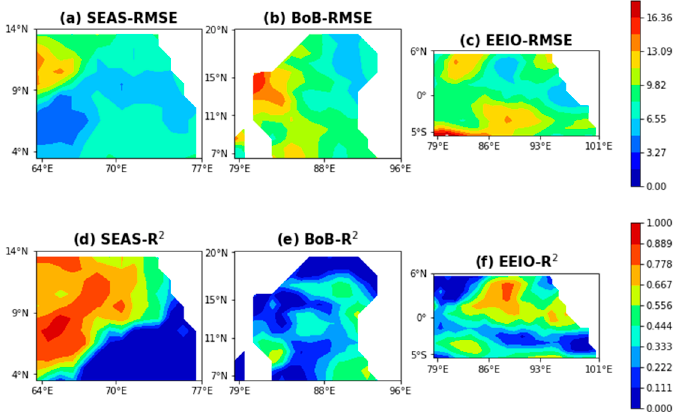
Figure 7. The RMSE (unit: m) ( above ) and R 2 ( below ) for Case 5. The computation is based on the estimated and Argo MLDs.